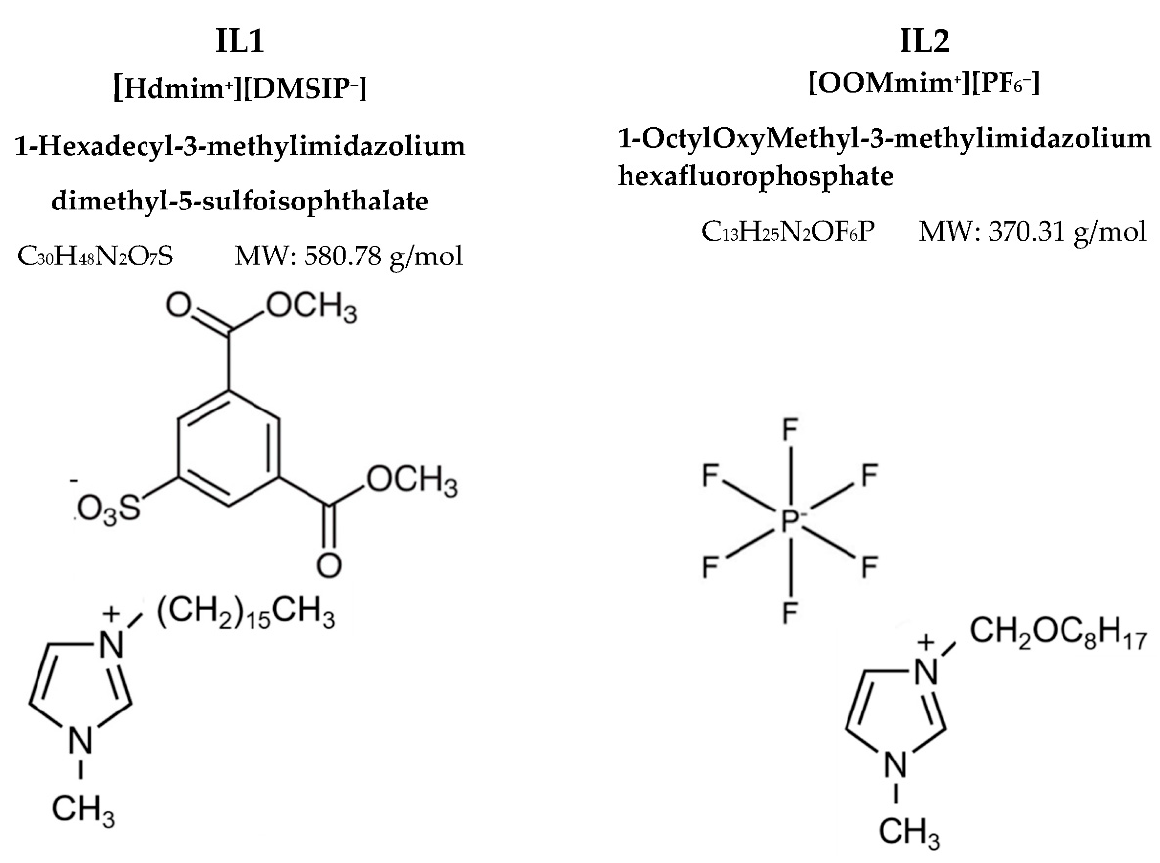
Figure 1. The chemical structures of the synthetized ILs.